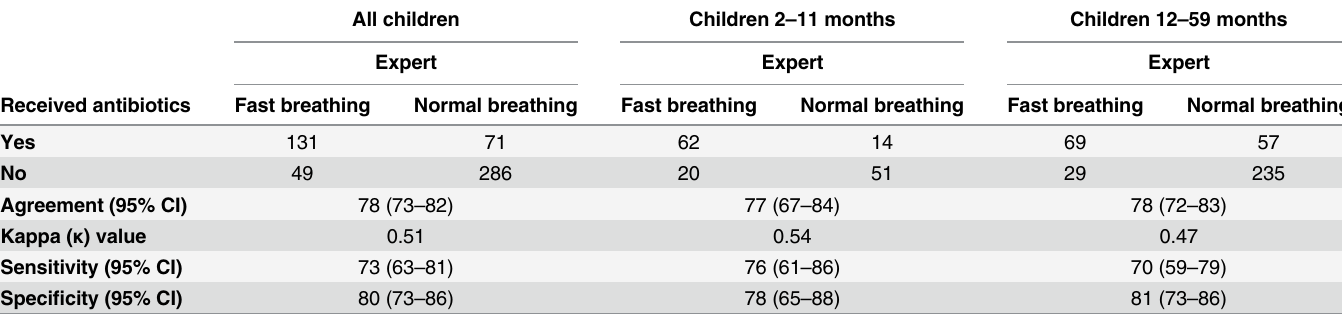
Table 3. Medication prescribed according to assessment of fast breathing by expert and child's